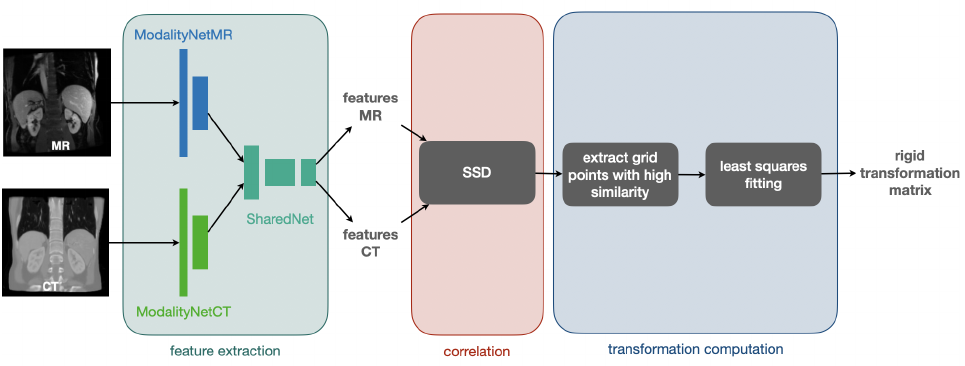
Figure 3. The process of feature extraction, correlation, and computation of the rigid transforma- tion matrix: A CNN is used for feature extraction starting with a separate network part for each modality (ModalitiyNetMR and ModalityNetCT) followed by a module with shared weights (Shared- Net). The obtained features are correlated by calculating patch-wise the sum of squared differences (SSD). Subsequently, grid points with high similarity are extracted and used to define point-wise correspondences to calculate the rigid transformation matrix with a least squares